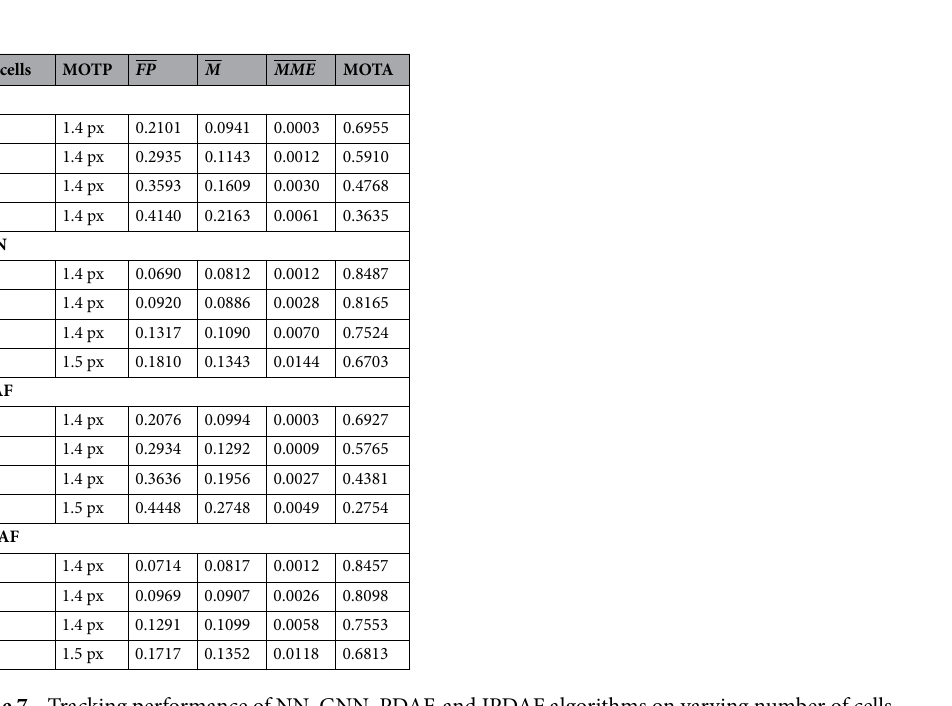
Table 7. Tracking performance of NN, GNN, PDAF, and JPDAF algorithms on varying number of